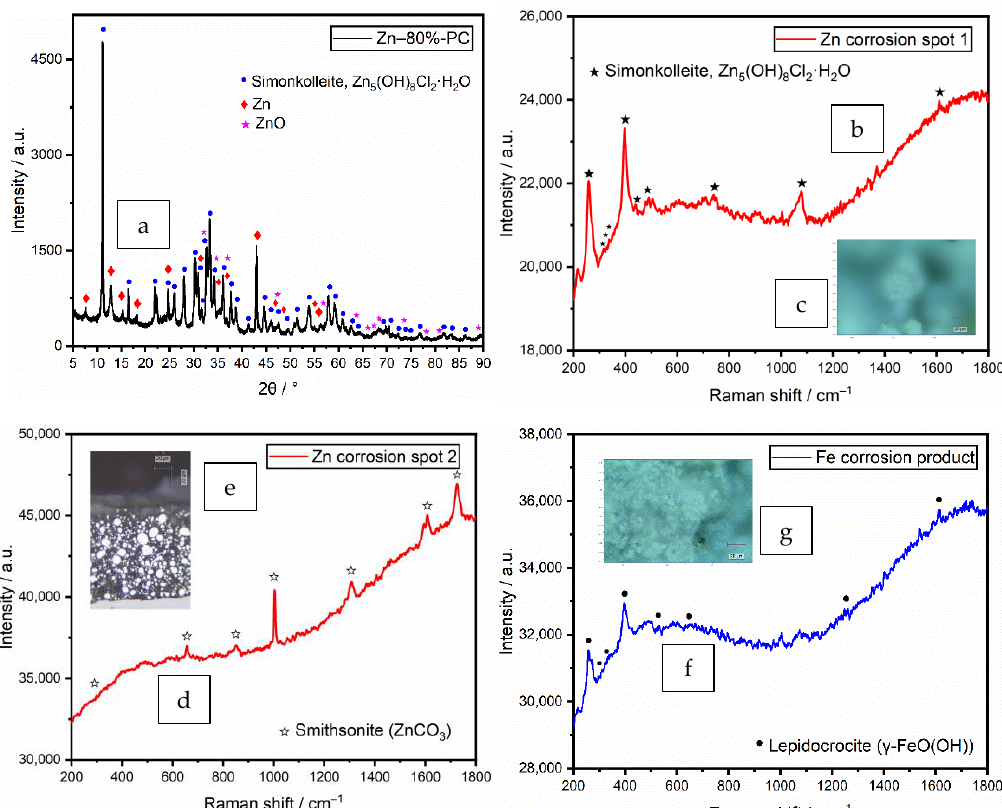
Figure 7. Spectra of a coating prepared from the formula Zn – 80%-PC after immersion test. ( a ) XRD pattern; ( b ) Raman spectrum of zinc corrosion products on coating surface; ( c ) spot with zinc corrosion product simonkolleite under an optical microscope; ( d ) Raman spectrum of zinc corrosion products near the coating surface in the cross-section; ( e ) spot with the zinc corrosion product smithsonite under optical microscope; ( f ) Raman spectrum of the iron corrosion product; ( g ) spot with the iron corrosion product lepidocrocite under an optical